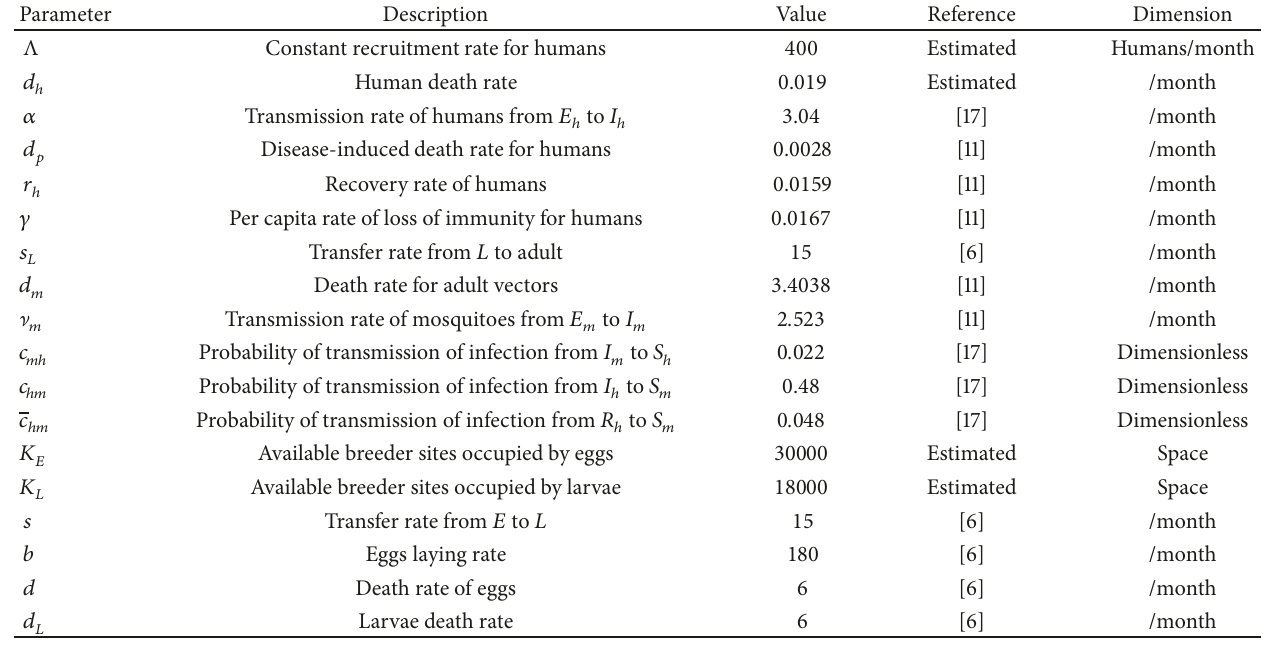
Table 1: Values for constant parameters for the malaria model.